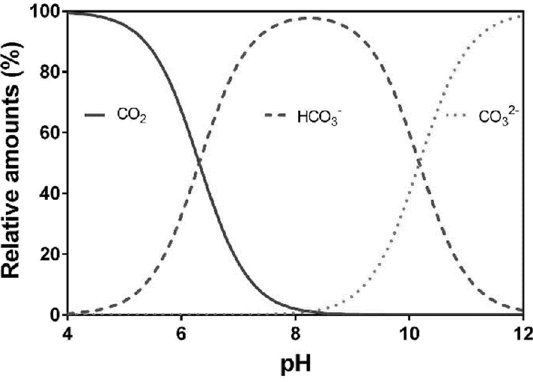
Figure 3. Relative speciation of CO 2 , HCO 3 − , and CO 32 − in water as a function of pH [8].